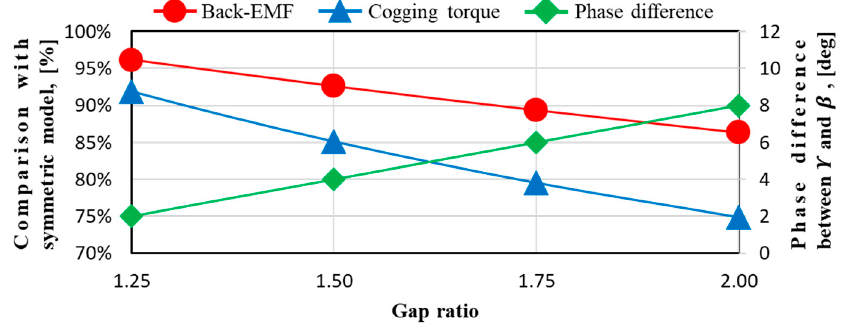
Figure 4. No load performance of tapered air gap according to length ratio.